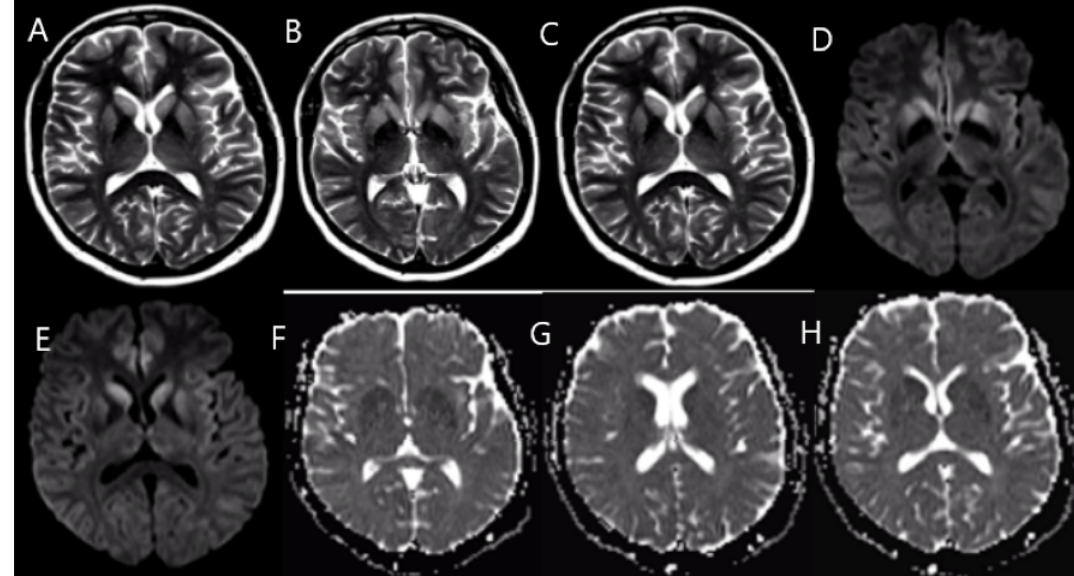
Figure 1. Brain magnetic resonance imaging scans demonstrating hypersignal in bilateral basal ganglia, insula, and anterior cingulate gyrus in T2 sequence (A, B, C) and hypersignal in the same regions in the diffusion sequence (D, E) with corresponding low signal in the ADC map (F, G, H), characterizing a true restriction to water